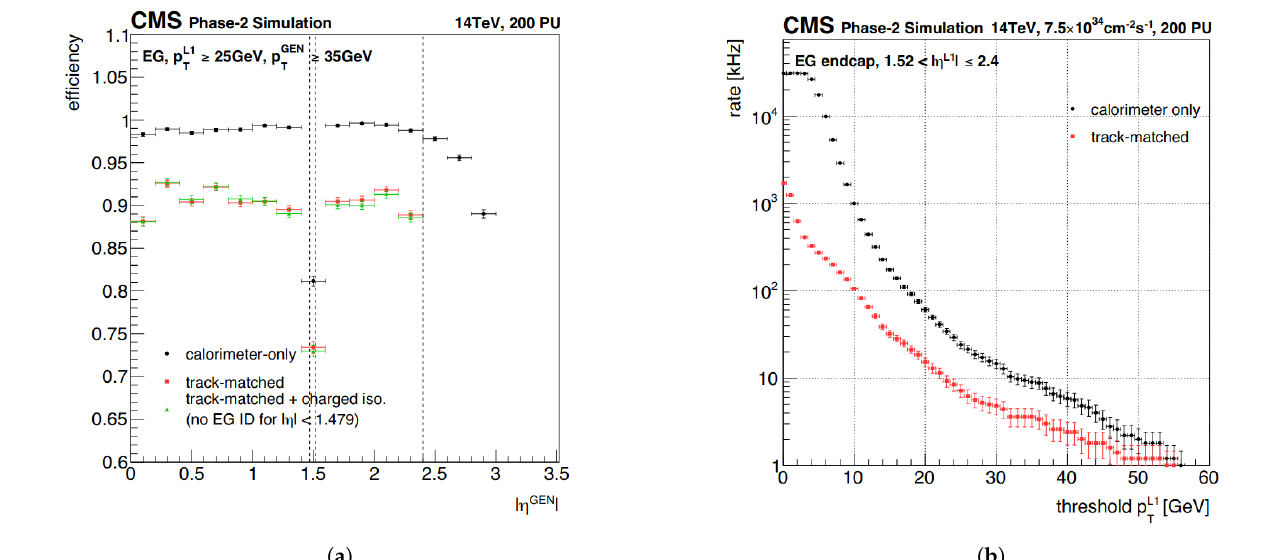
Figure 10. Performance comparison between standalone and track-matched e / γ trigger objects: ( a ) Trigger efficiency as a function of the generator-level | η | ; ( b ) Trigger rate as a function of the threshold on the L1 objects’ p T